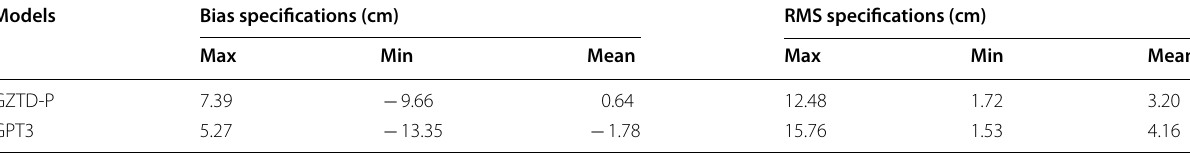
Table 2 The performance of the GZTD-P and GPT3 models validated at radiosonde stations Models Bias specifications (cm)